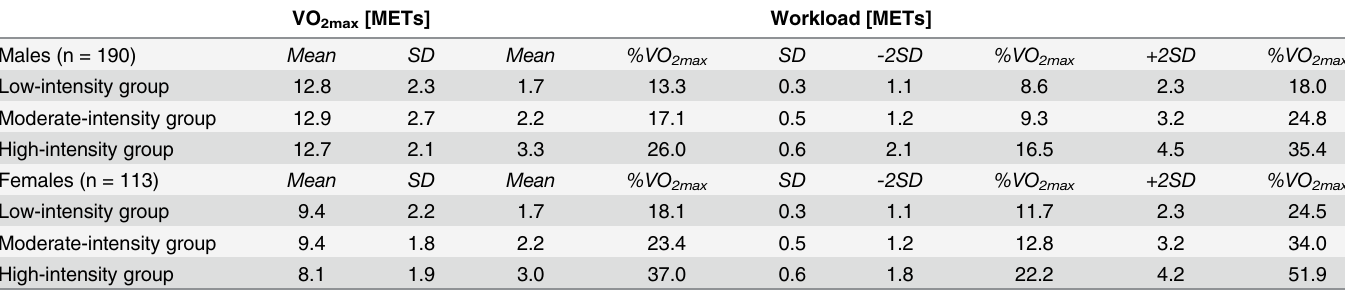
Table 2. Ratio of workload to maximum work capacity according to occupational group and gender.